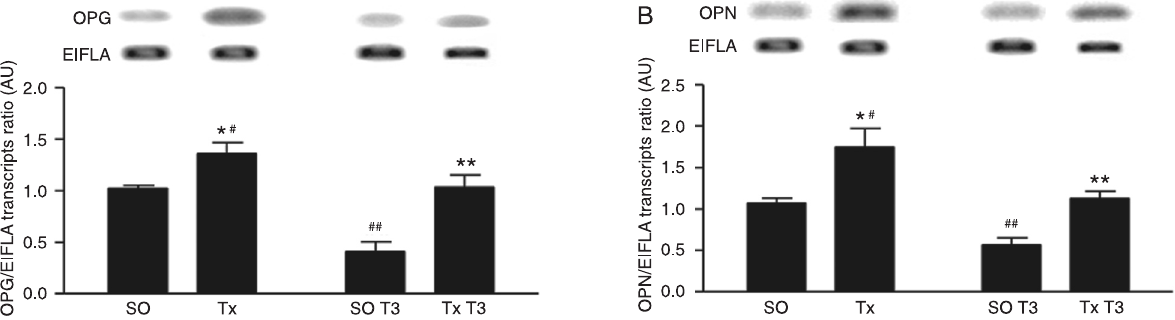
Figure 1. Triiodothyronine (T3) decreases osteoprotegerin (OPG) and osteopontine (OPN) mRNA expression in the rat maxilla. Panels A and B show the OPG and OPN mRNA content, respectively, in the maxilla of sham-operated (SO), thyroidectomized (Tx), sham- operated T3-treated (SO T3), and Tx rats chronically treated with T3 (Tx T3). The T3 dose used was 5 μg/100 g body weight for 15 days. Typical representative images of OPG, OPN and EIFLA gene expression are given at the top of the panels. Three experiments were performed with 4 animals per group (N = 48). Data are reported as means ± SEM, expressed in arbitrary units (AU), and were analyzed by two-way analysis of variance (ANOVA), followed by the Bonferroni post-test. *P < 0.0001 vs SO; **P < 0.0001 vs SO T3; # P < 0.0001 vs Tx T3; ## P < 0.0001 vs SO.